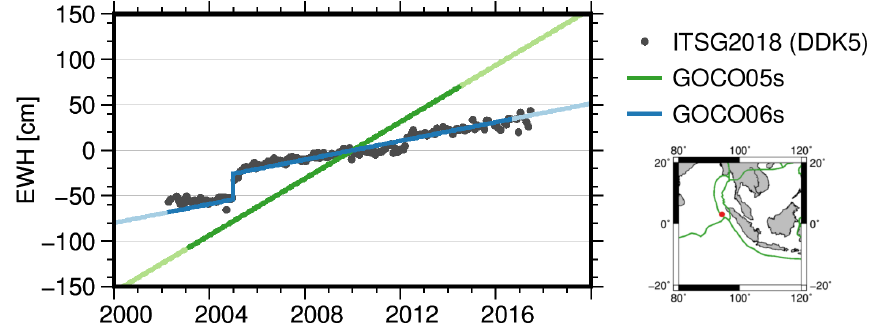
Figure 7. Comparison of estimated secular variation from GOCO05s, GOCO06s (including estimated co-seismic mass change) and filtered GRACE monthly solutions in terms of equivalent water height (EWH). The gravity field solutions were evaluated at 94.1 ◦ E, 3.1 ◦